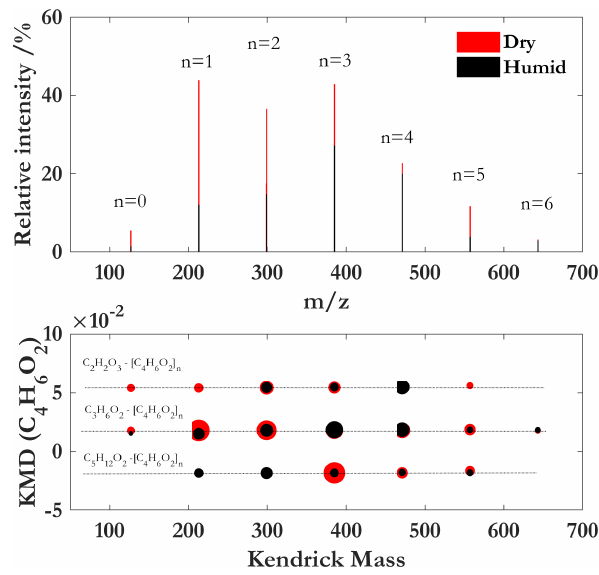
Figure 11. Positive mode mass spectra of oligomers with CH 2 OO as chain units in SOA from isoprene-NO 2 irritations under dry and humid conditions (a) and corresponding plots of KMD (CH 2 OO) vs. nominal KM (CH 2 OO) (b) . The horizontal lines connect the family of compounds with an equal elemental composition differing only by [CH 2 OO] n ( n = 0 , 1 , 2 , 3 ... ) groups.